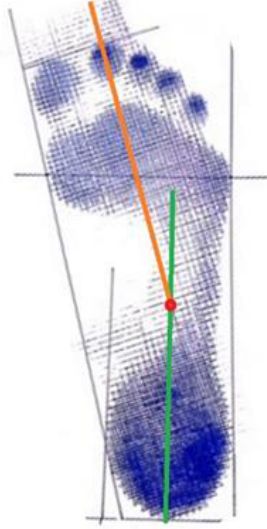
Figure 1. Footprint with measurements according to the method described by Bunch.